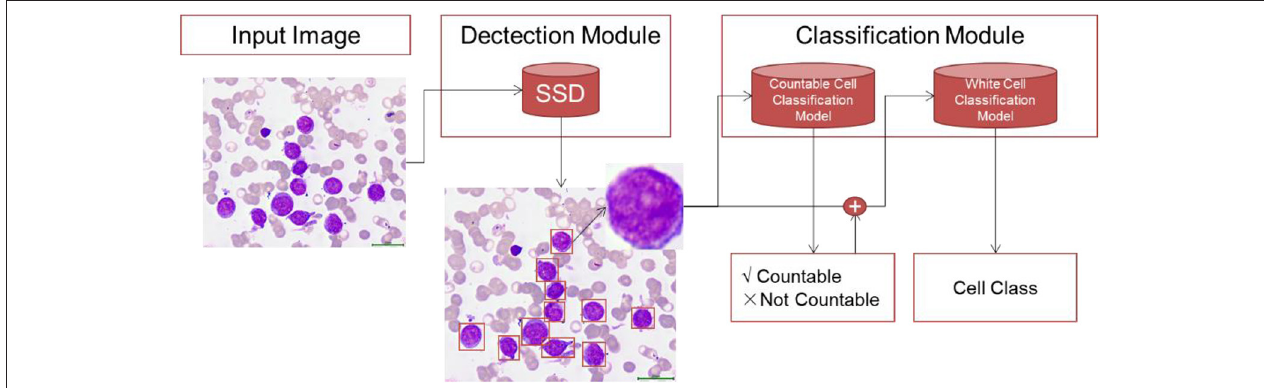
FIGURE 3 | The overall modeling framework containing two modules: detection module and classification module. In the detection module, we train detection model using RetinaNet method to detect all the WBCs in bone marrow images. The classification module contains two stage. In the first stage, we develop a countable cell classification model to discriminate crush white blood cell which would not be counted by hematologists. Then in the second stage, the detected countable white blood cells are submitted to classification model for WBC classification.